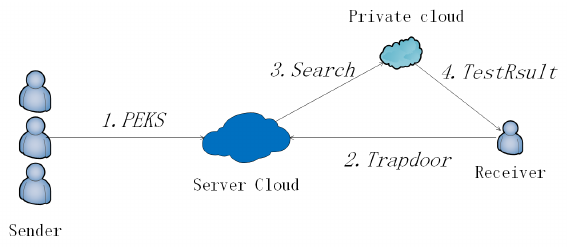
Figure 5. PEKS with the Private